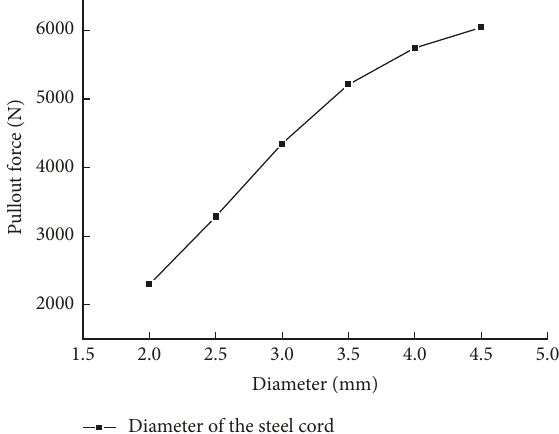
2.0 Diameter of the steel cord Figure 9: The change in pullout force with different steel cord experimental pullout force with time for different steel cord different numbers of steel cords and simulated. As shown in numbers is obtained in Figures 13(a) and 13(b), respectively. Figure 12, there are two and four steel cord conveyor belt When the number of steel cord is increased from one to models. Simulations were performed on 50.0 mm long four, the pullout force also increases. However, compared to models of the single steel cord. The numerical and